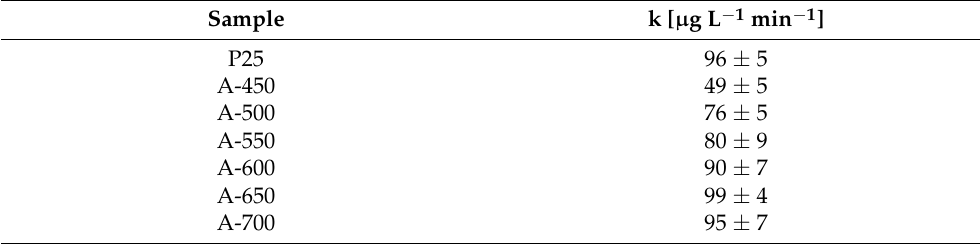
at different temperatures ( γ (TiO 2 ) = 0.25